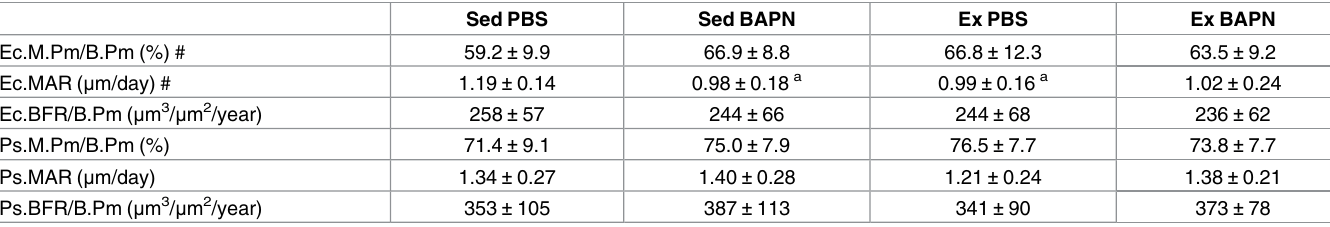
Table 2. Dynamic histomorphometry of tibial